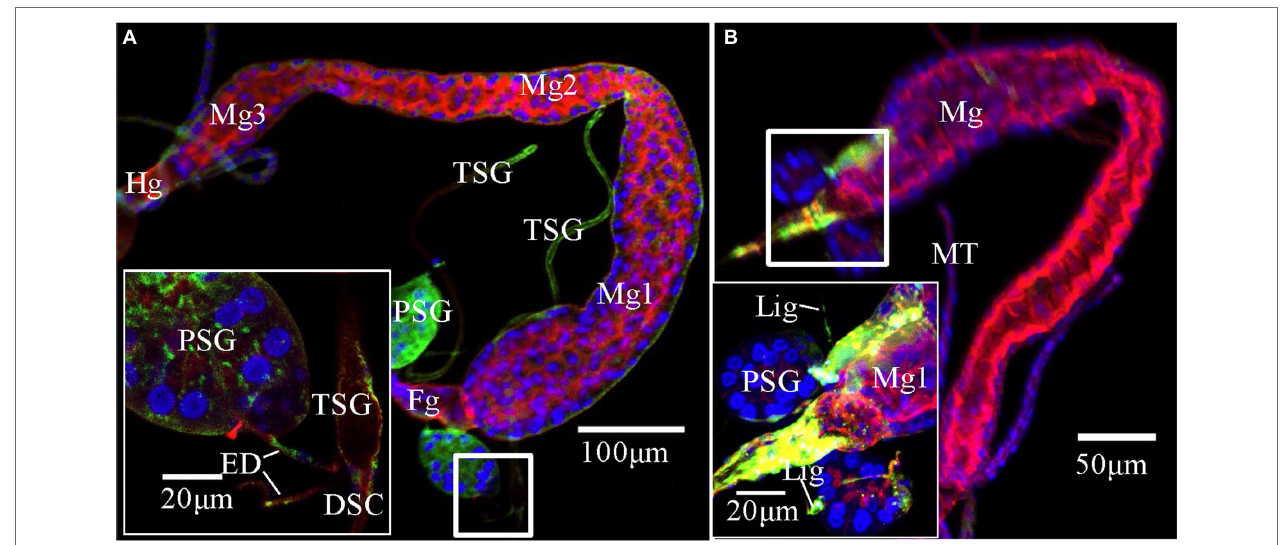
FIGURE 3 | Potential route of tomato zonate spot virus (TZSV) infecting the primary salivary glands (PSGs) of Frankliniella occidentalis. TZSV-infected samples were immunolabeled with the actin dye phalloidin-rhodamine (red), the nuclear dye DAPI (blue), and the nucleocapsid protein of TZSV (TZSV-N) conjugated to fluorescein isothiocyanate (green) and observed under a confocal laser scanning microscope. (A) TZSV-N locates to the midgut 2, hindgut, PSGs, and efferent ducts connecting PSGs and tubular salivary glands (TSGs; second instar, 48 h padp). The boxed area indicates the localization of the virus in the efferent ducts, TSGs, and PSGs. (B) TZSV-N localizes to the foregut, midgut 1, PSGs, and ligaments connecting the PSGs and midgut 1 (second instar, 48 h padp). Abbreviations: DSC, deferent salivary canal; ED, efferent duct; Fg, foregut; Lig, ligament; Mg, midgut; MT, Malpighian tubule; PSG, primary salivary gland; TSG, tubular salivary gland.